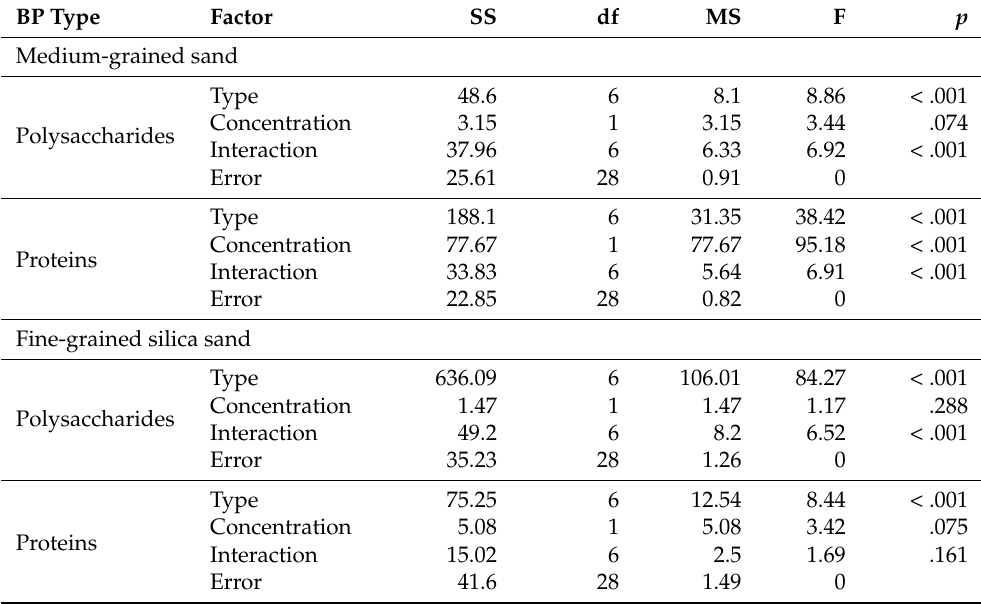
Table 5. Results of two-way ANOVA ( α = .05) of average calculated crust thickness.